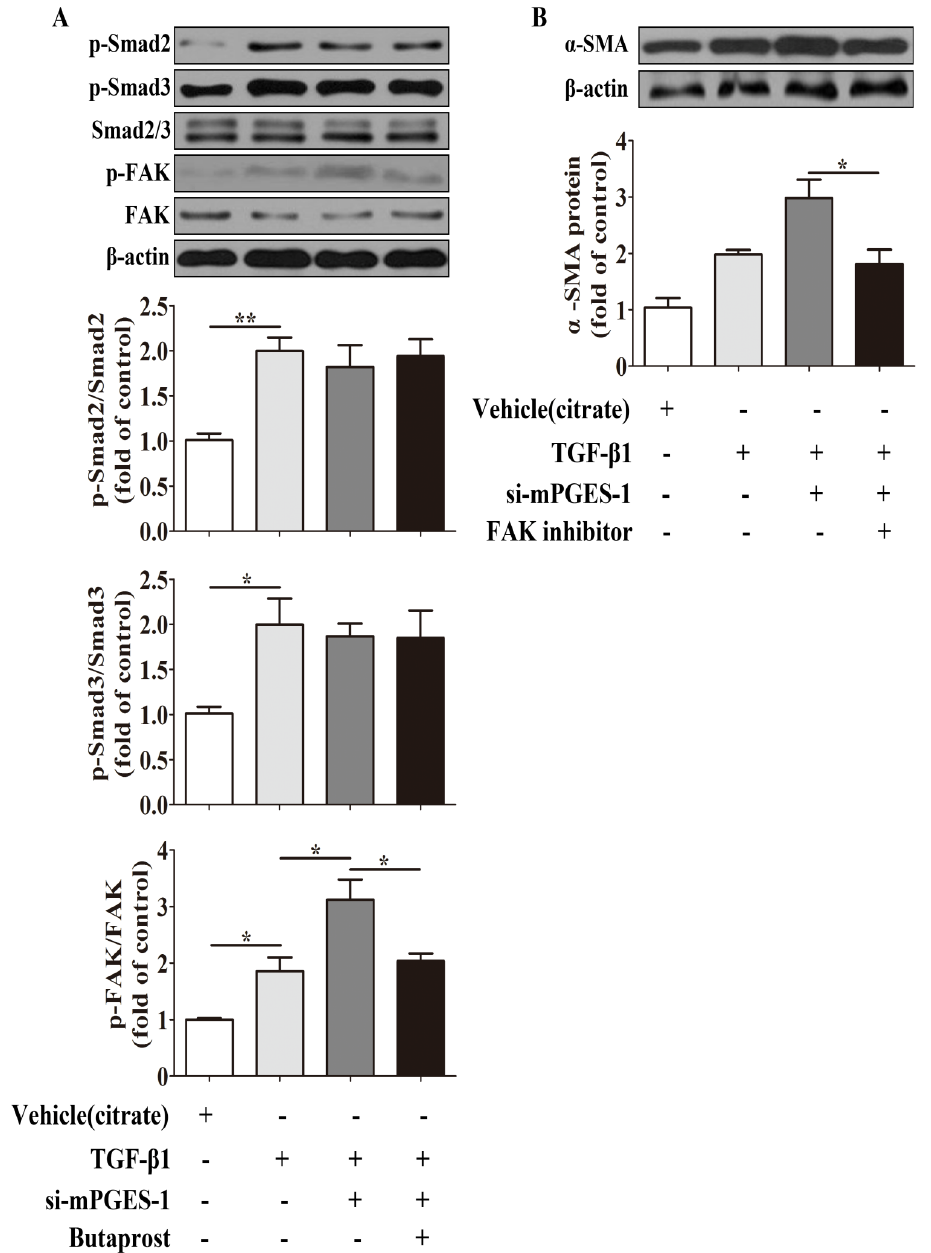
Figure 7. mPGES-1-derived PGE Exerts a Beneficial Effect against α -SMA Expression 2 Induced by TGF- β 1 in MRC-5 Cells via inhibition of FAK autophosphorylation. After starvation and siRNA transfection, the cells were co-incubated with TGF- β 1 and EP2 agonist (butaprost, 100 nmol/mL) for 24 h or with TGF- β 1 and FAK inhibitor (FAK inhibitor 14, 10 μ mol/mL) for 24 h. ( A ) Butaprost, EP2 agonist, decreased p-FAK protein expression induced by TGF- β 1 in MRC-5 cells with mPGES-1 siRNA transfection; ( B ) Inhibition of FAK autophosphorylation reduced α -SMA protein expression after TGF- β 1 and mPGES-1 siRNA co-incubation in MRC-5 cells. Results are expressed as means ± SEM ( n = 3) ( * p < 0.05, ** p < 0.01, si-mPGES-1,